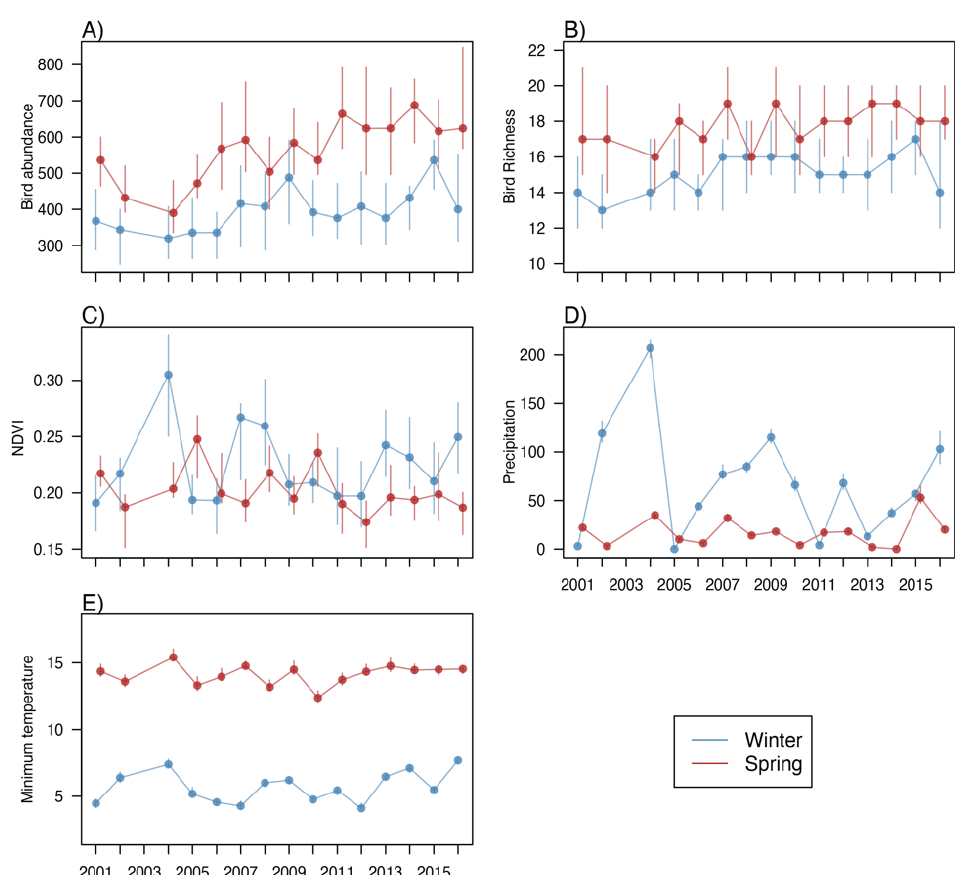
Figure 2. Seasonal patterns of avian abundance ( A ) and richness ( B ), normalized difference vegetation index—NDVI ( C ), precipitation, expressed in mm ( D ), minimum temperature, expressed in ◦ C ( E ), across Phoenix in central Arizona. The median and the confidence interval are displayed on the boxplot. Data are shown for the spring and winter seasons.